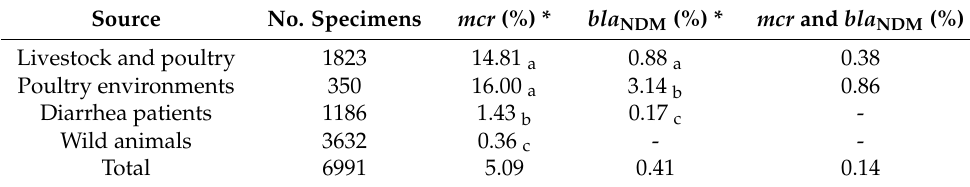
Table 1. Positive rate of bla NDM and mcr in gut specimens from various